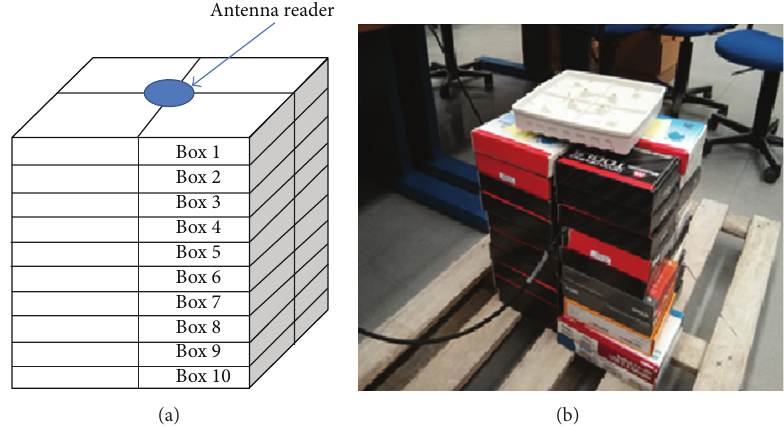
Figure 4: Radials of received power for different materials for the center of the first row of boxes.